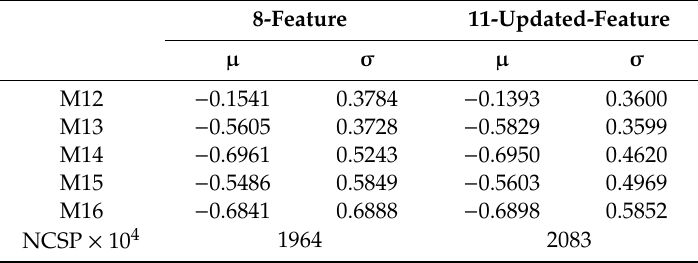
Table 5. The O-M biases for 8-feature and 11-updated-Feature on 11 March 2019. ( µ stands for O-M bias and σ is standard